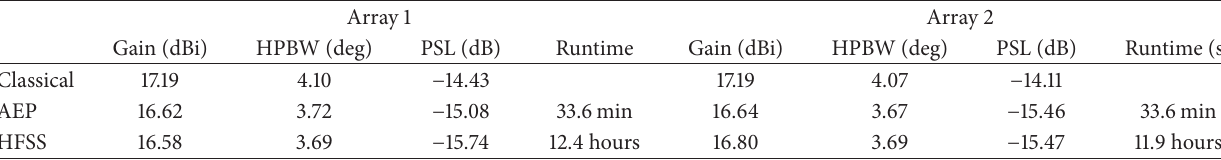
Table 2: Gain pattern performance of planar thinned arrays.